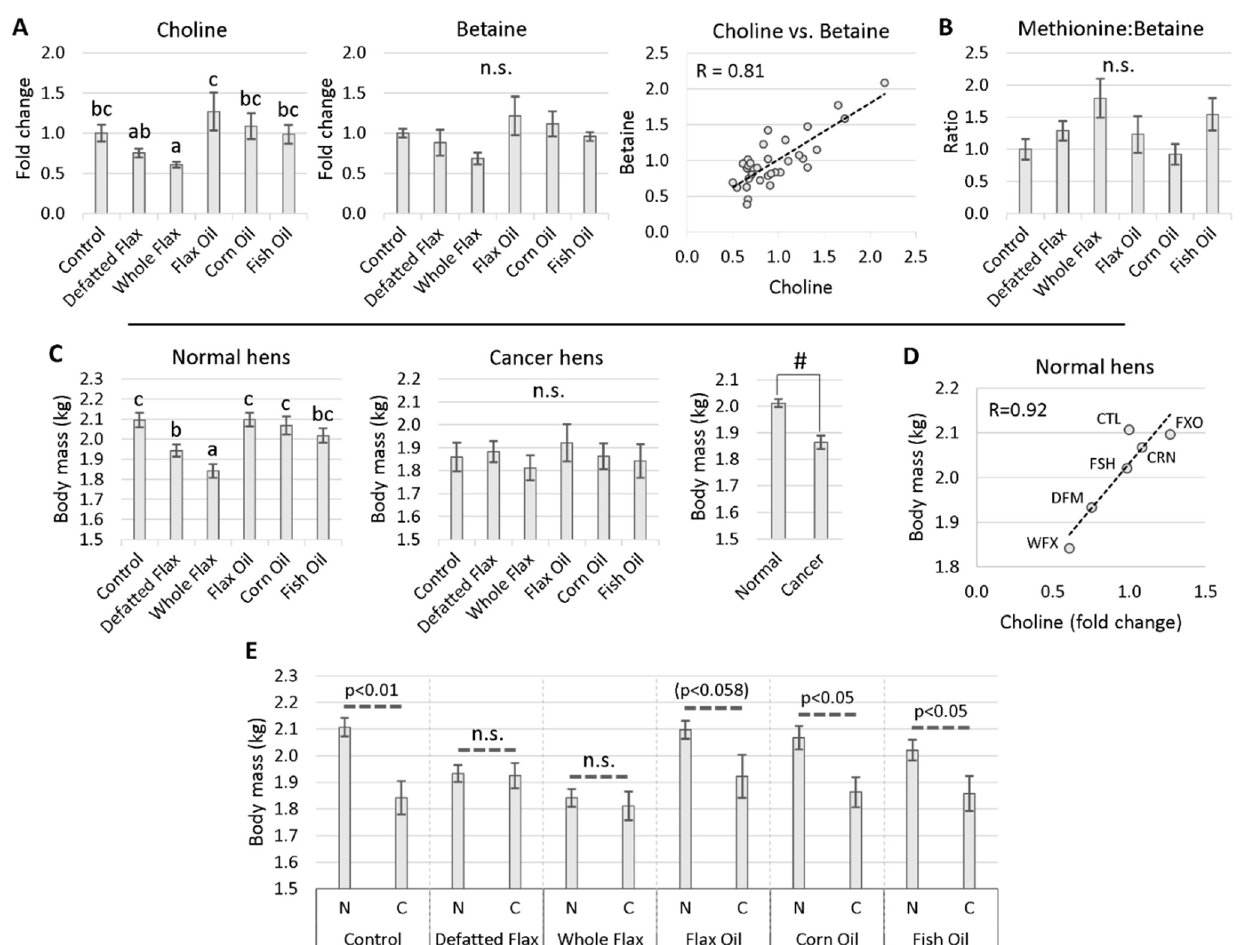
Figure 5. One-carbon donor molecules that fuel BHMT, in association with hen body mass: Hen plasma samples were measured via LC-MS/MS. VIP scores of metabolites were analyzed via one-way ANOVA (Duncan’s post-test, p < 0.05). Groups lacking a similar letter (i.e., a,b,c) are significantly different. “n.s.” is used to illustrate a non-significant ANOVA or T-test. Choline and betaine were evaluated in plasma ( A ), and the Met:betaine ratio was observed ( B ). We tested the effect of diet on body mass, using one-way ANOVA (Duncan’s post-test, p < 0.05) ( C ). Body mass was also contrasted between normal hens and cancerous hens, using the Student’s t -test for unequal variance (two-tailed; “ # ” indicates p < 0.01) ( C ). The Pearson coefficient between mean body mass and mean choline content was measured ( D ). In ( E ), the body masses between cancerous hens (“C”) and normal hens (“N”) were compared within diets, using the Student’s t -test for unequal variance. The sample sizes for groups in ( E ) are, by order of appearance: 86, 31, 85, 23, 73, 22, 84, 22, 62, 29, 70, and 24. The sample size from each group in ( A ) is listed in the Materials and Methods section (Section 5.3). The sample size from each group in ( C ) is listed in the Materials and Methods section (Section 5.2). One outlier was removed from the whole flax diet group in the graph of choline ( A ). Error bars are +/ − SEM.